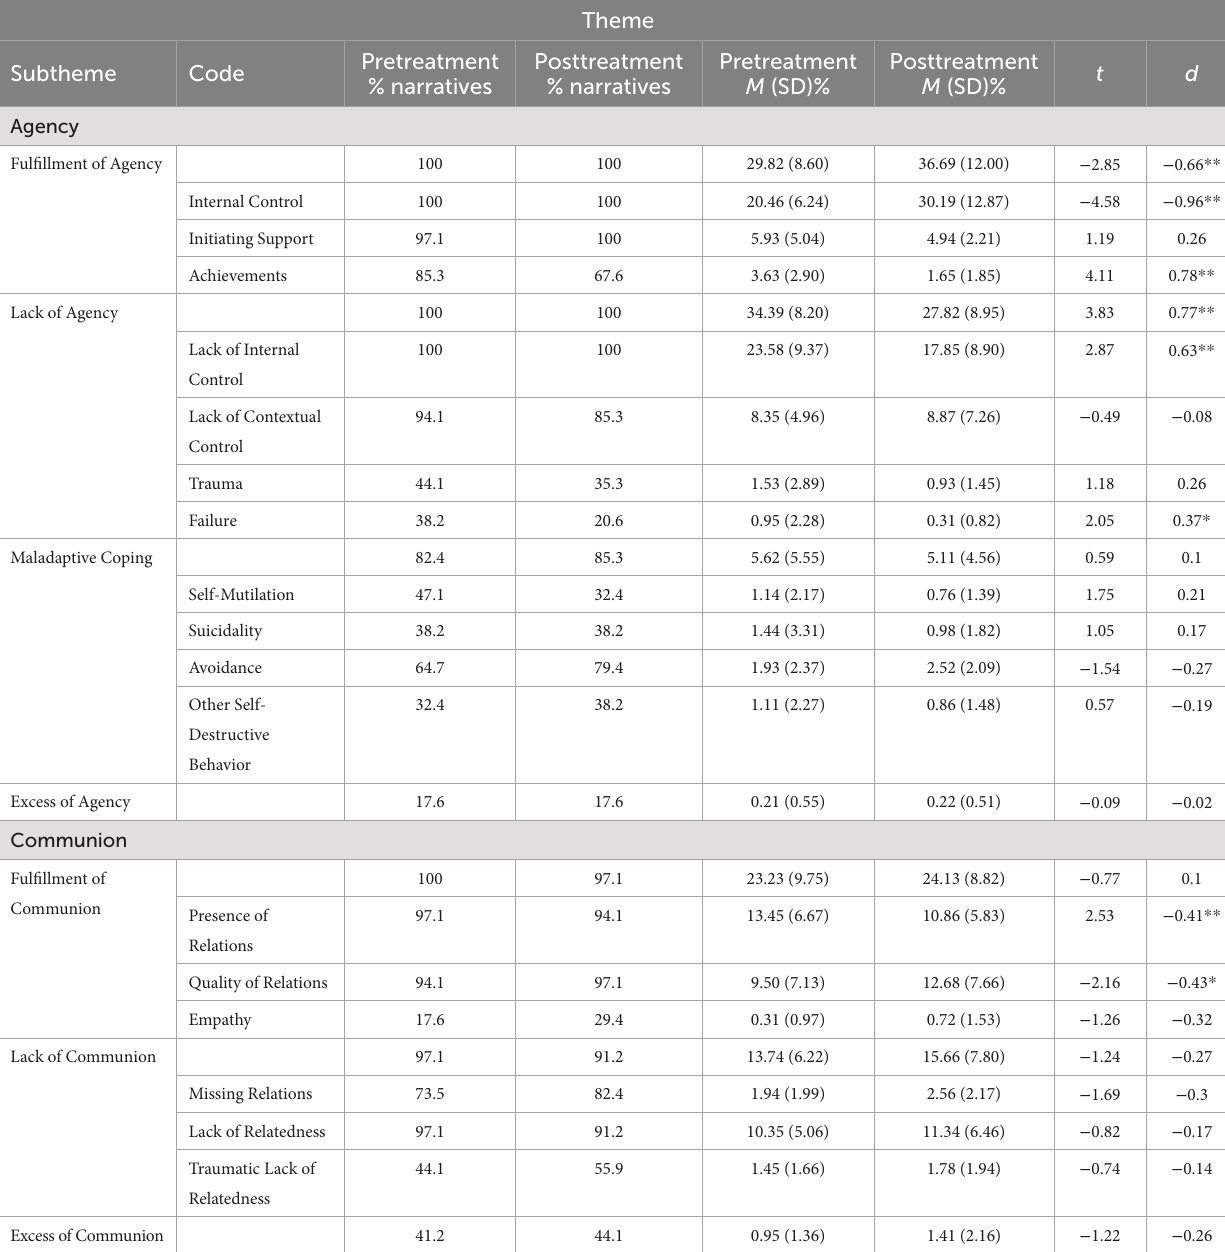
TABLE 3 Percentages of narratives, mean proportion of meaning units and standard deviation (between parentheses), paired t -test ( t ), and effect sizes (Cohen’s d) for subthemes and codes comparing pre and posttreatment.